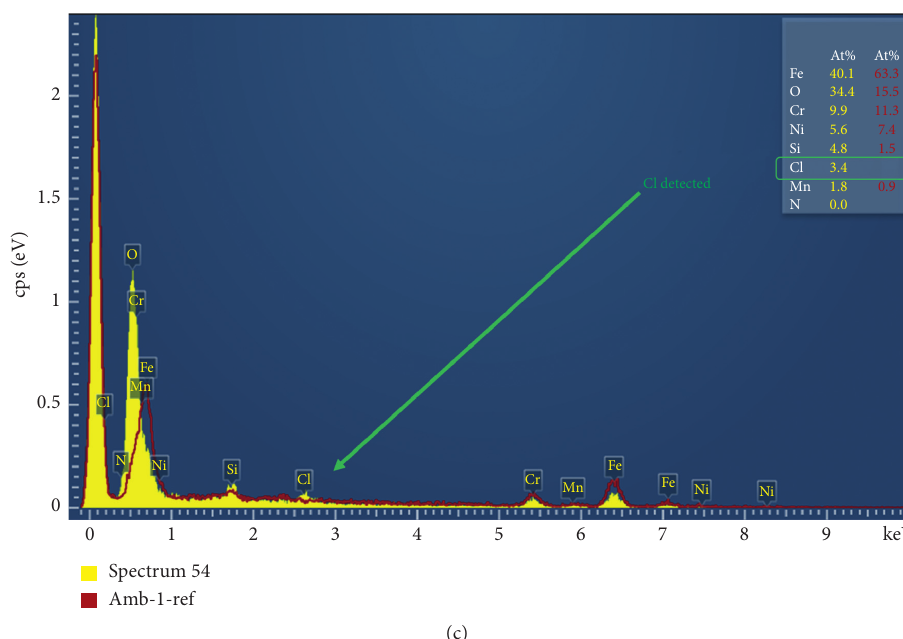
Figure 7: Detection of Cl in test with brine. (a) TN07 brine, edge of wear mark. (b) TN07 brine, high